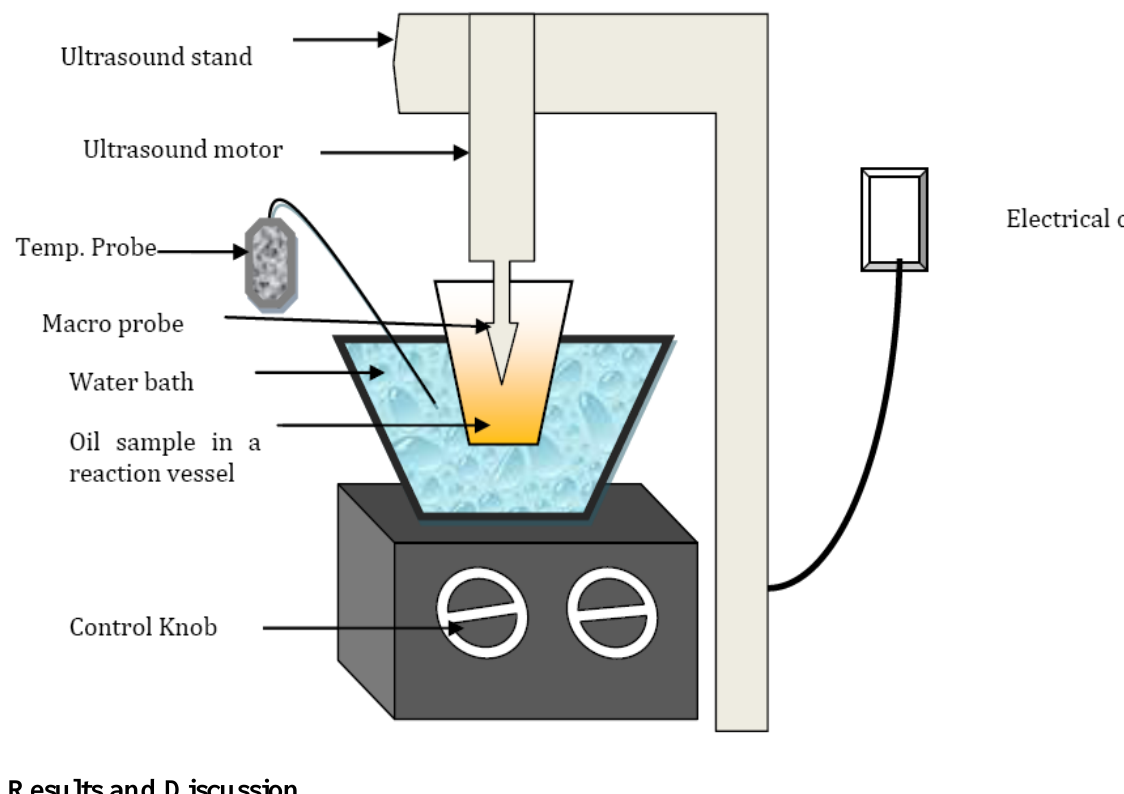
Figure 1. Experimental set up of the ultrasonic